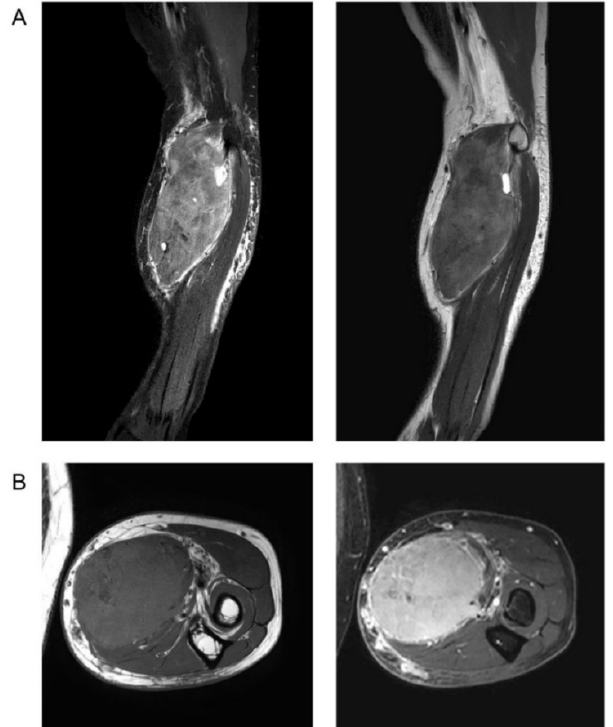
Figure 4. MRI of a patient with a suspected benign neurofibroma according to the initial MRI report. Histopathology after biopsy showed high-grade spindle cell sarcoma (NOS). ( A ). Sagittal T2-weighted sequence with fat saturation (left) and without fat saturation (right). ( B ). Axial T1-weighted sequence before (left) and after application of contrast agent with fat saturation (right).